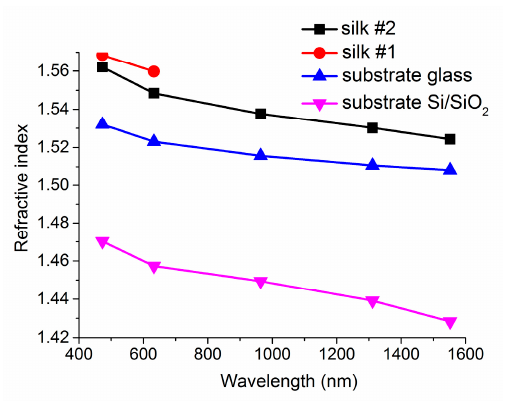
Figure 7. The refractive indices of silk planar optical waveguides deposited on silica-on-silicon (silk #1) and glass substrates (silk #2).